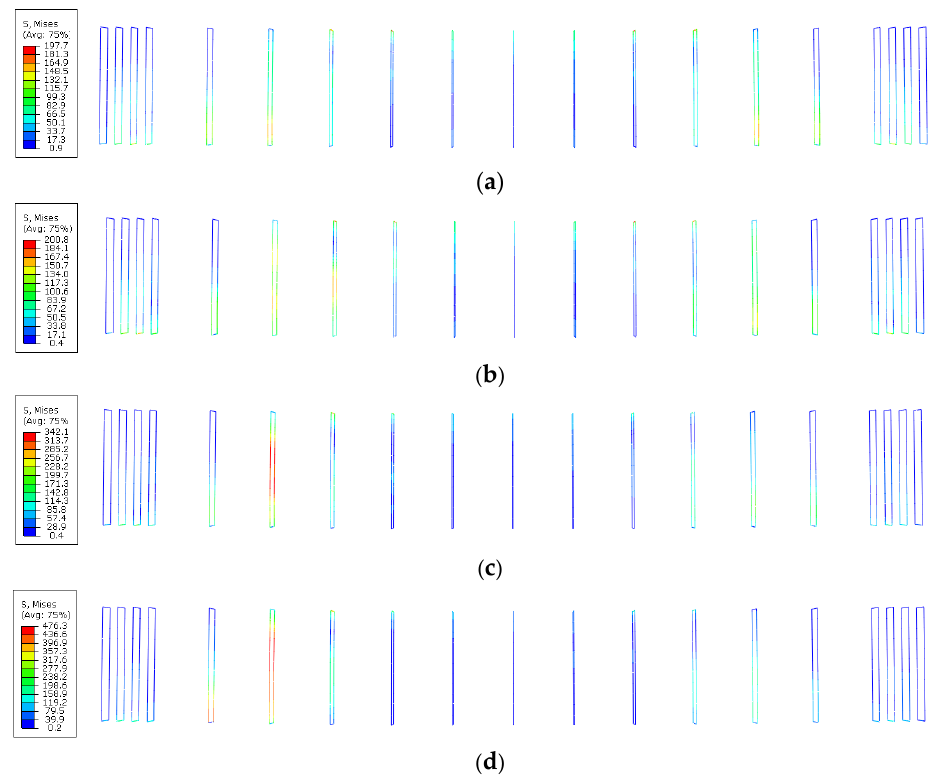
Figure 10. Stress diagram of stirrups. ( a ) B1 beam; ( b ) B2 beam; ( c ) B3 beam; ( d ) B4